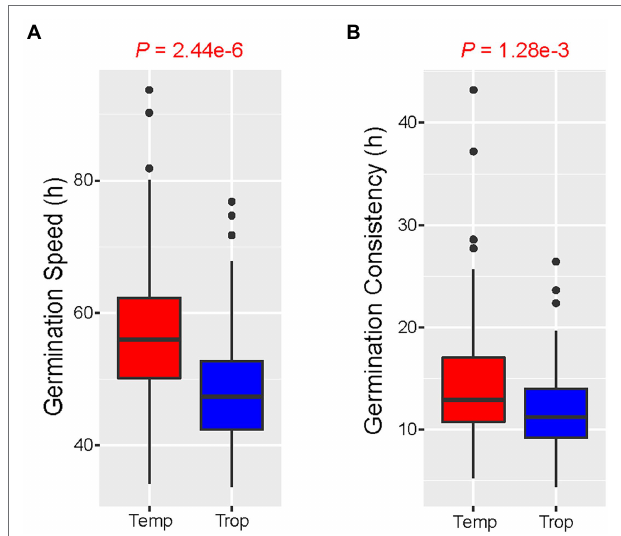
FIGURE 8 | Boxplot of germination traits in a different subpopulation. (A) Analysis of variance to examine the difference in germination speeds between temperate and tropical subpopulations. (B) Analysis of variance to examine the differences in germination consistency between temperate and tropical